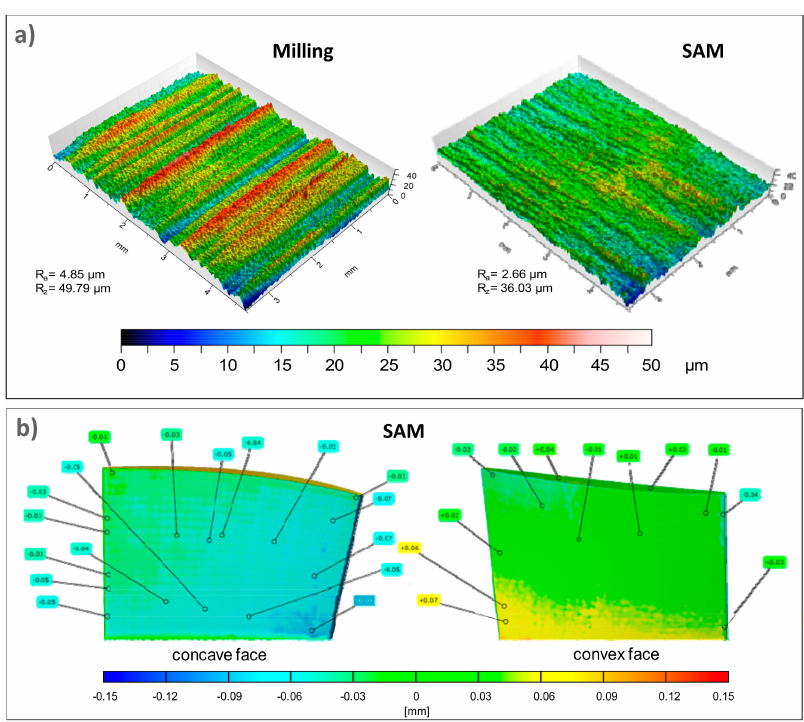
Figure 1. SAM vs. conventional milling obtained results: roughness ( a ) and dimensional deviation ( b ) [27].